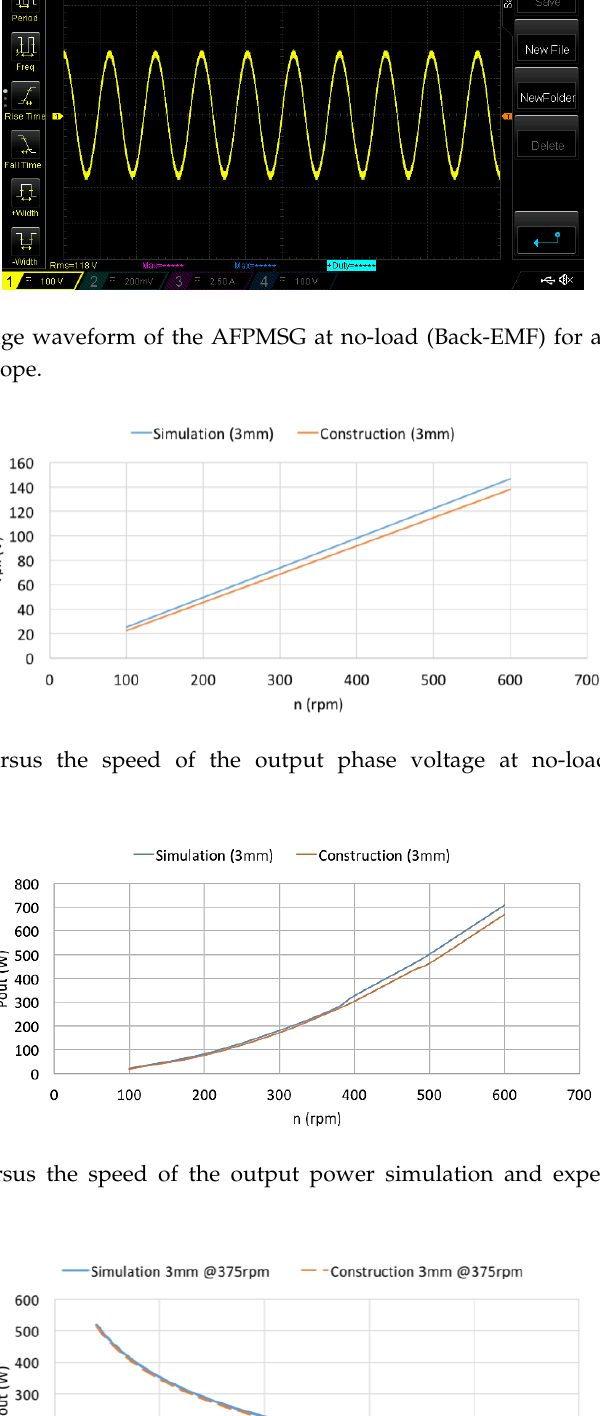
Figure 11. Plot versus the load per phase of the output power simulation and experimental results for a speed of 375 rpm.